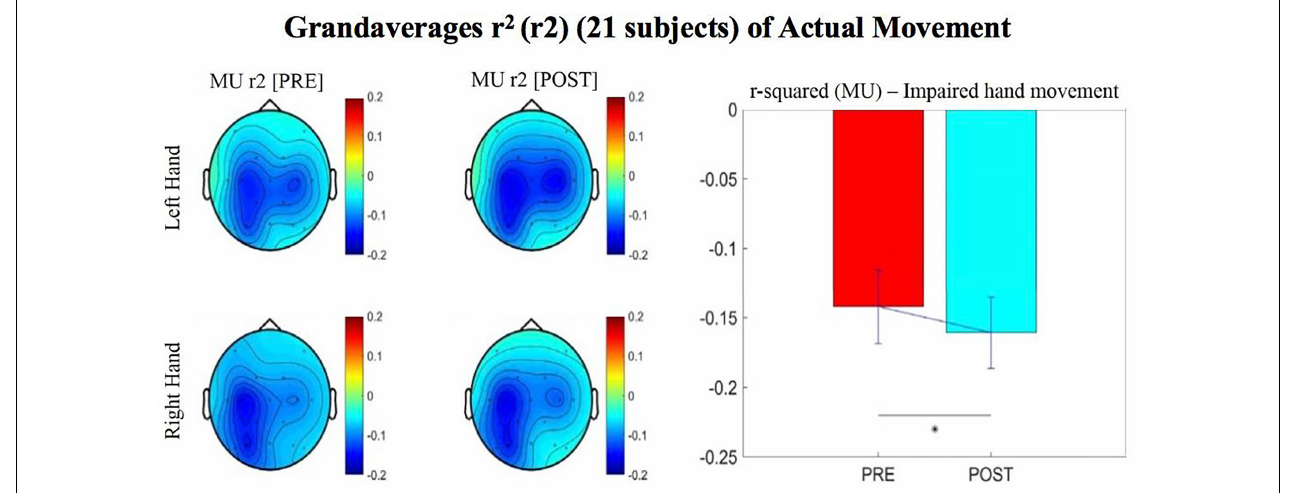
FIGURE 4 | Topographical plots (topoplots) of grand averages for Mu rhythm (8–12 Hz) signed r-squared values at group level ( n = 21). The bar plot shows the group means for the Mu rhythm signed r-squared values from the impaired hand attempted movement trials (vs. rest) at ipsilesional electrode site. Asterisk denotes statistical significance from a one-tailed paired t -test ( p < 0.05). Error bars denote standard error of the mean. The majority of participants were left hand impaired. Prescreening, open-looped training (PRE) and open-looped post screening BCI training (POST) runs (color bar: [–0.2 = blue – 0.2 = red]). The majority of participants had a right lateralized lesion.